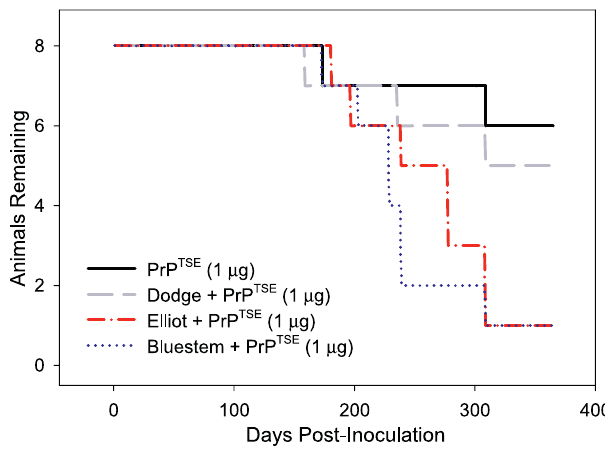
Figure 5. Prions Bound to Whole Soils Remain Orally Infectious and Some Soils Increase Transmission Three soils (Dodge, Elliot, and Bluestem) were incubated in the presence of purified PrP TSE . The samples were orally dosed into hamsters and found to remain orally infectious. Agent association with Elliot and Bluestem soils increases disease incidence, whereas Dodge soil does not influence disease transmission. Animals dosed with soil alone remained healthy throughout the course of the experiment (unpublished